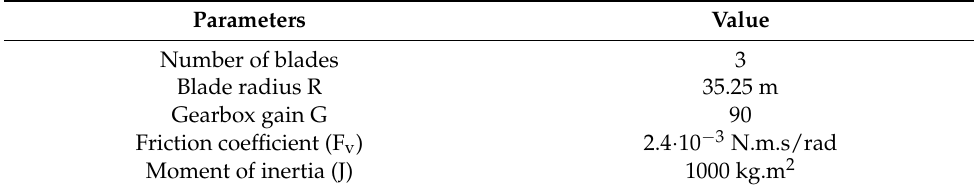
Table 2. Parameters of the